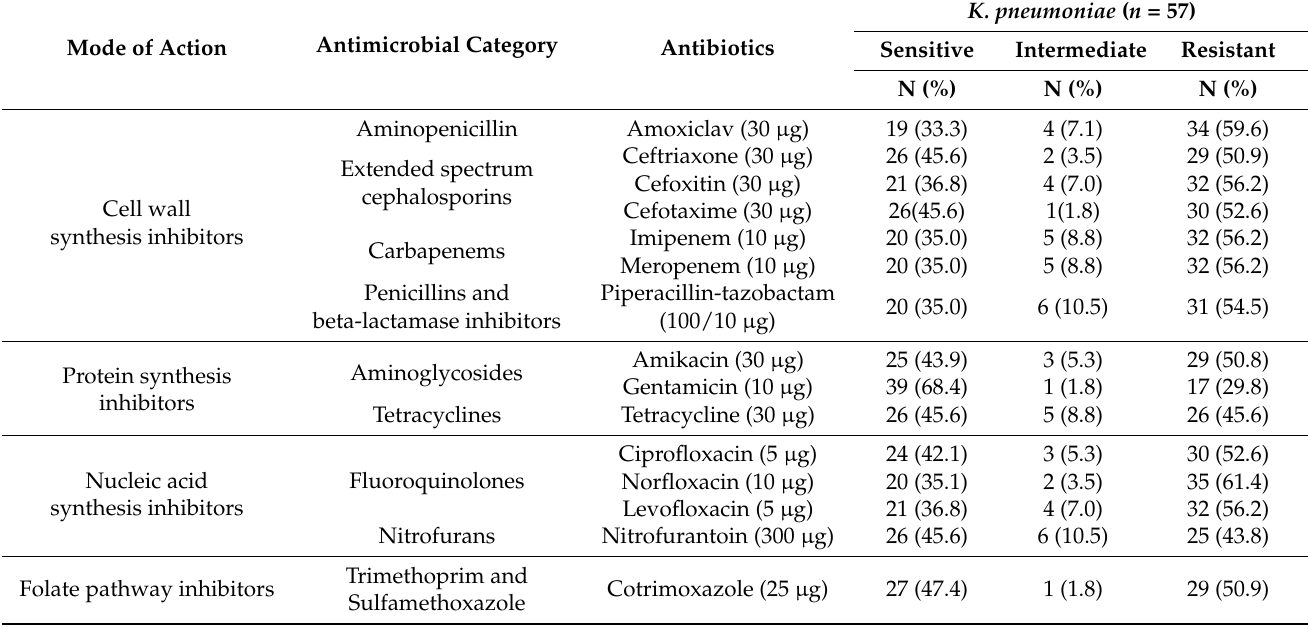
Table 3. Antibiotic susceptibility profile of Klebsiella spp. ( n = 57).